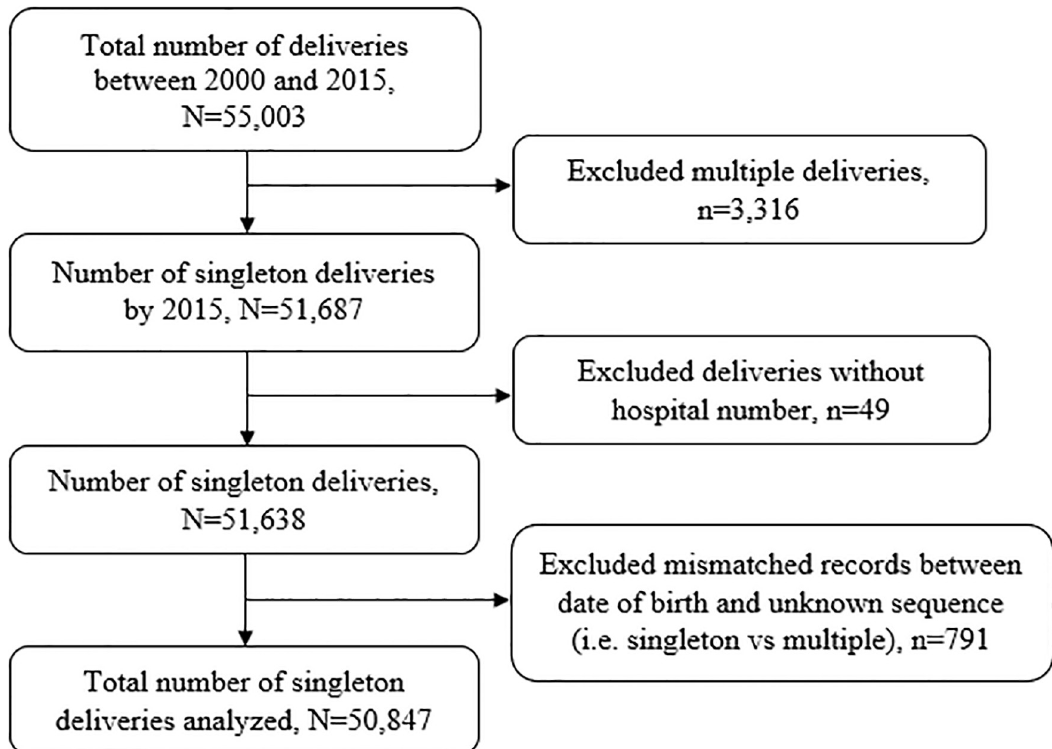
Fig 1. Schematic diagram showing the number of participants, KCMC medical birth registry, 2000–2015.